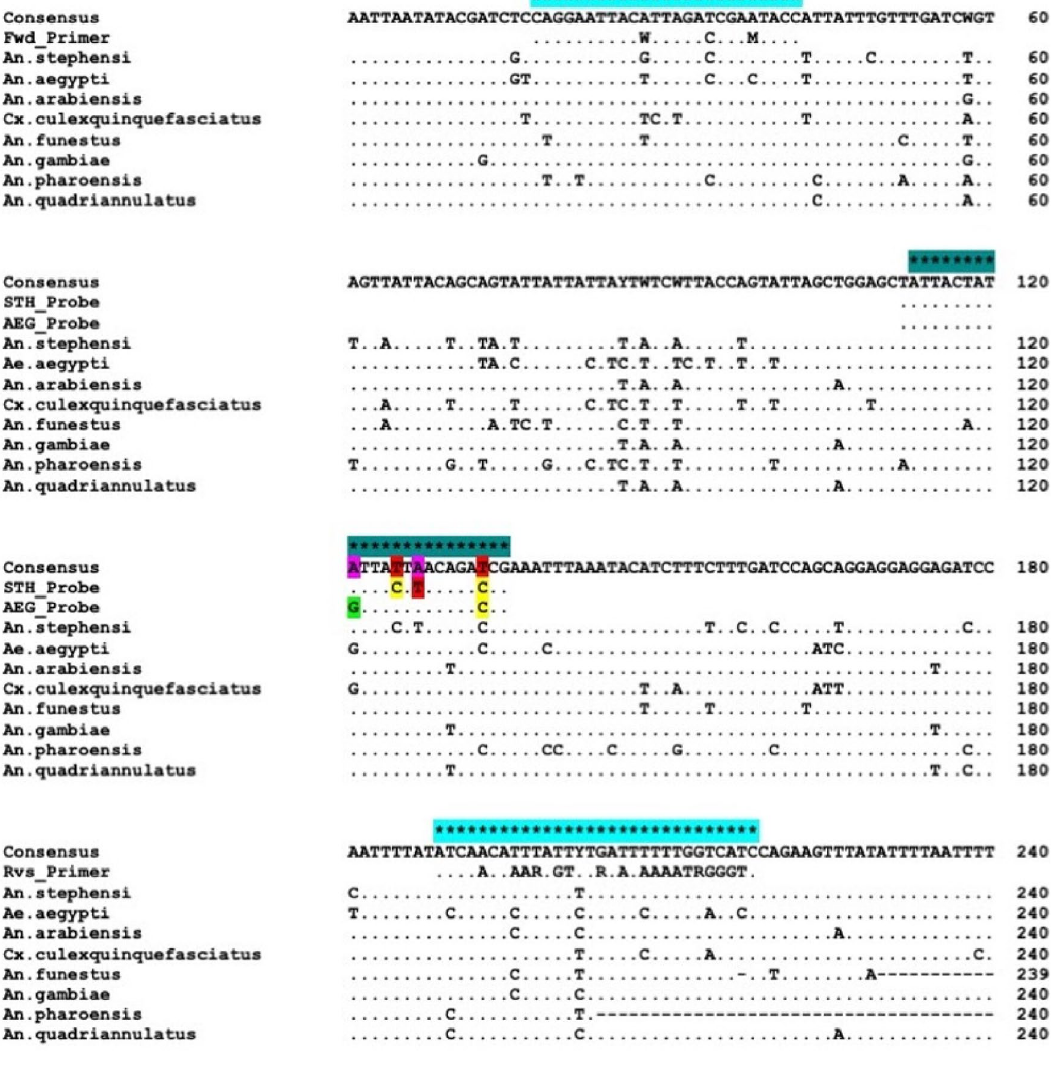
Figure 5. Consensus alignment of reference COXI sequences used for primer and probe design. Positions of forward and reverse primers are highlighted by light blue asterisks. Species-specific probes are highlighted in teal, with single-nucleotide polymorphisms in